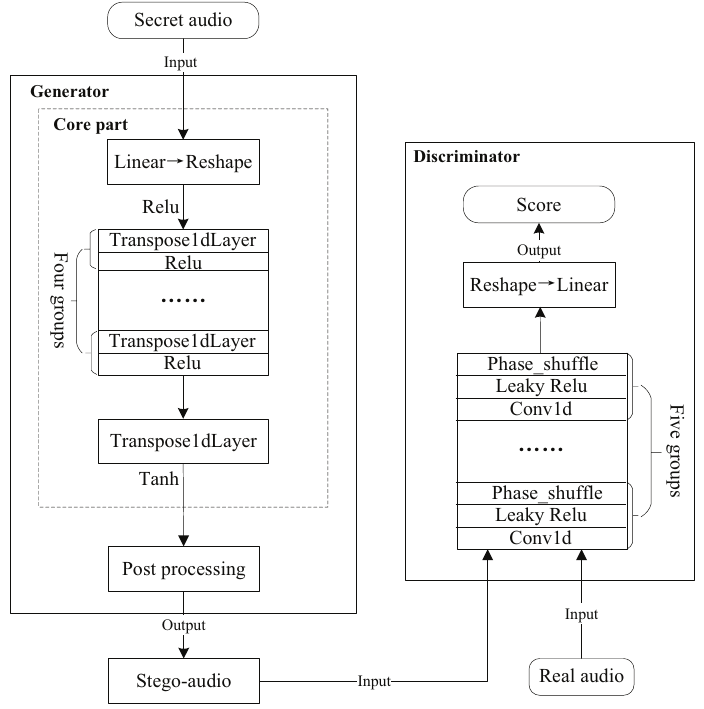
Figure 2. The generator and discriminator